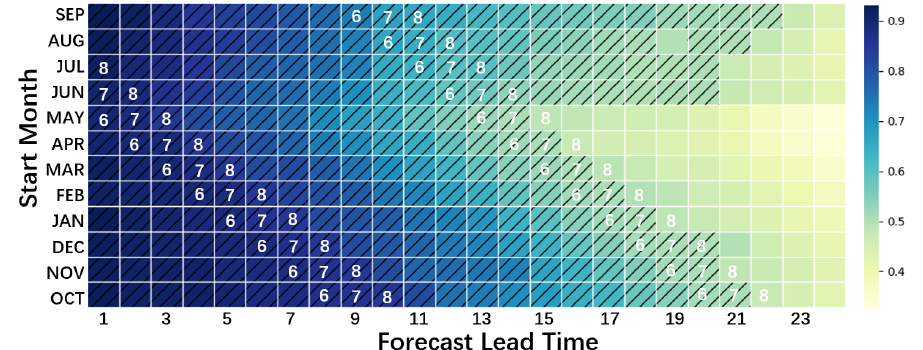
Figure 15. The correlation skill heat map between the forecast results of the ENSO-ASC and real-world observations on Niño 3.4 index with different forecast start months over the validation period. The hatching cells represent the correlations exceed 0.5, and the white numbers on the cells mean the calendar